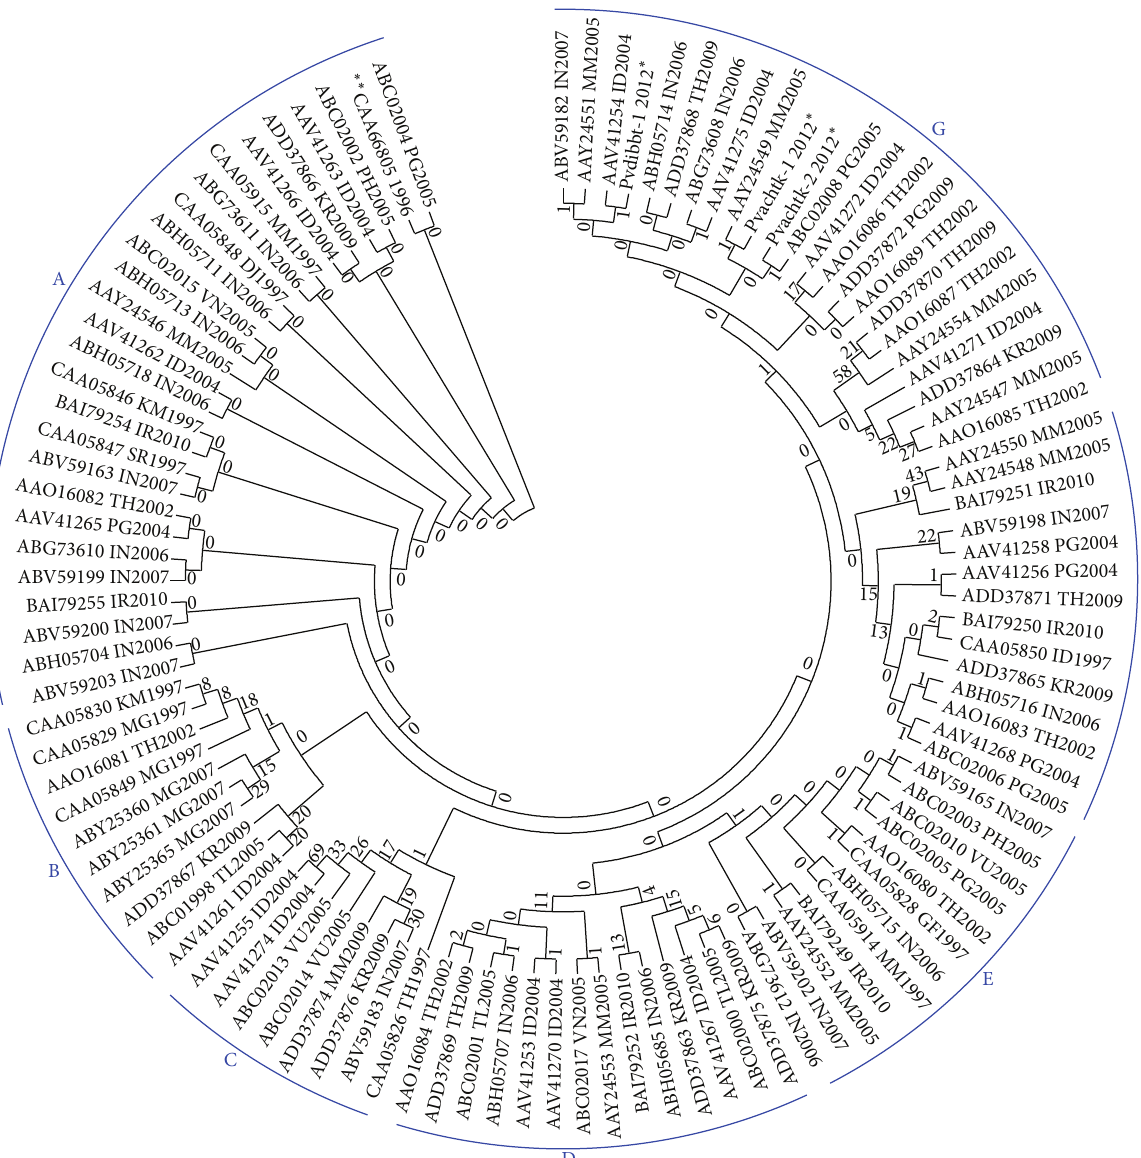
Figure 3: Phylogenetic relationship of P. vivax dihydrofolate reductase (DHFR) homolog. The multiple sequence alignment of all representative DHFR homologs of P. vivax MDR malaria parasite populations was carried out at both nucleotide and amino acid levels. The phylogenetic reconstruction of haplotypes, which was tested 1000 times with bootstrap method, was constructed based on the maximum parsimony method by using the MEGA ver. 5.22 [76]. DHFR haplotypes and haplogroups (A to G) of geographically prone P. vivax parasites conferring point mutations responsible for resistance against antifols and sulfones/sulfonamides are shown in supplementary File S4 (see Supplementary Material available online at http://dx.doi.org/10.1155/2014/969531). As retrieved from the GenBank genome database, all the nucleotideoraminoacidsequences(accessionnumbers)of P.vivax DHFRhomologscorrespondtotheinfectionsourcesofthegeographically prone P. vivax isolates including Pvdibbt-1 (KC121333), Pvachtk-1 (KC121334), and Pvachtk-2 (KC121335). The GenBank files of these three isolates are shown in supplementary Files S1 to S3. The qualifier of the submitted sequences pertaining to country or geographic area and submission year was used in the phylogenetic analysis. The isolation sources analyzed include the majority of patient isolates of geographically prone P. vivax parasites and a very lesser extent by ∗ mosquito isolates and ∗∗ laboratory strain of P. vivax asexual blood stage.